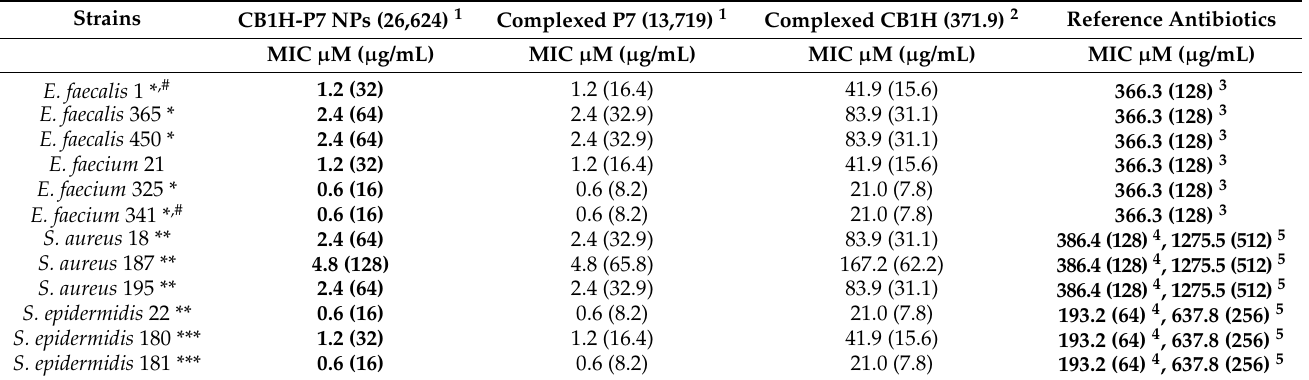
Table 5. MIC values of CB1H-P7 NPs and those of P7 and CB1H in the complex against bacteria of Gram-positive species, obtained from experiments carried out in triplicate, and those of reference antibiotics expressed as µ M and µ